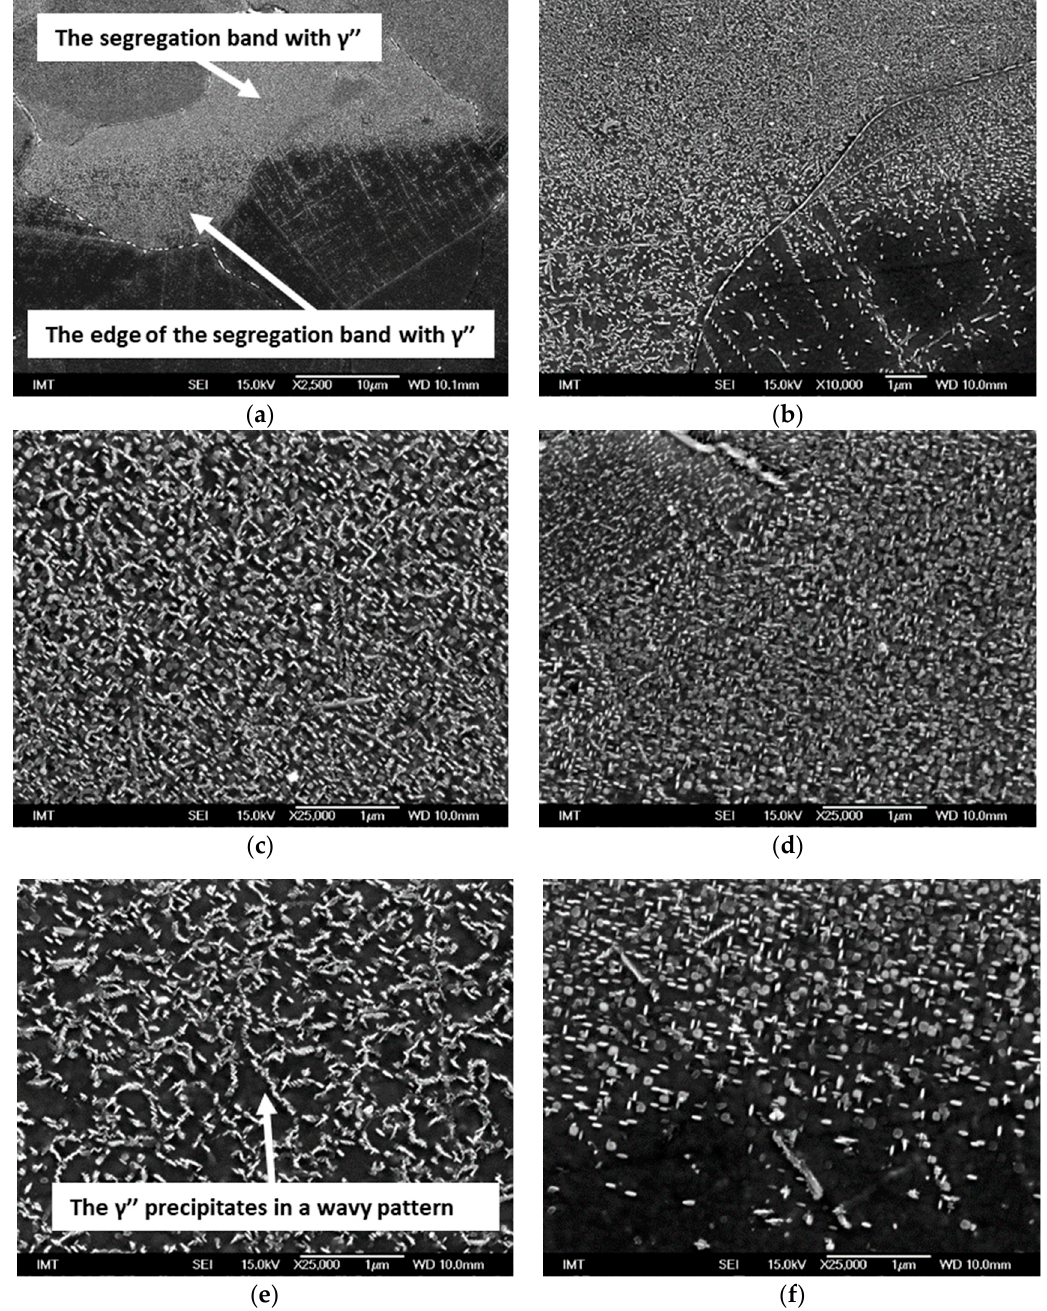
Figure 10. Segregation band of the sample hot rolled at 1150 ◦ C with the deformation level of 14.4% and aged at 750 ◦ C for 5 h ( a , b ). The precipitation of the γ ” in the segregation band of deformed grain ( c ) and recrystallized grain ( d ). The wavy pattern of the γ ” precipitates in the deformed grain at the edge of the segregation band ( e ). The γ ” precipitation in recrystallized grain at the inner edge of the segregation band ( f ).